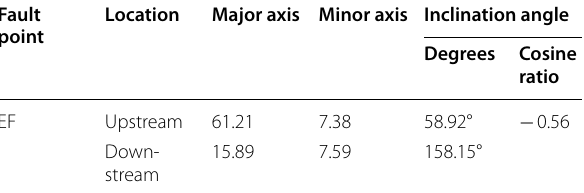
Table 8 Ellipse characteristic quantity of fault at EF Fault Location point